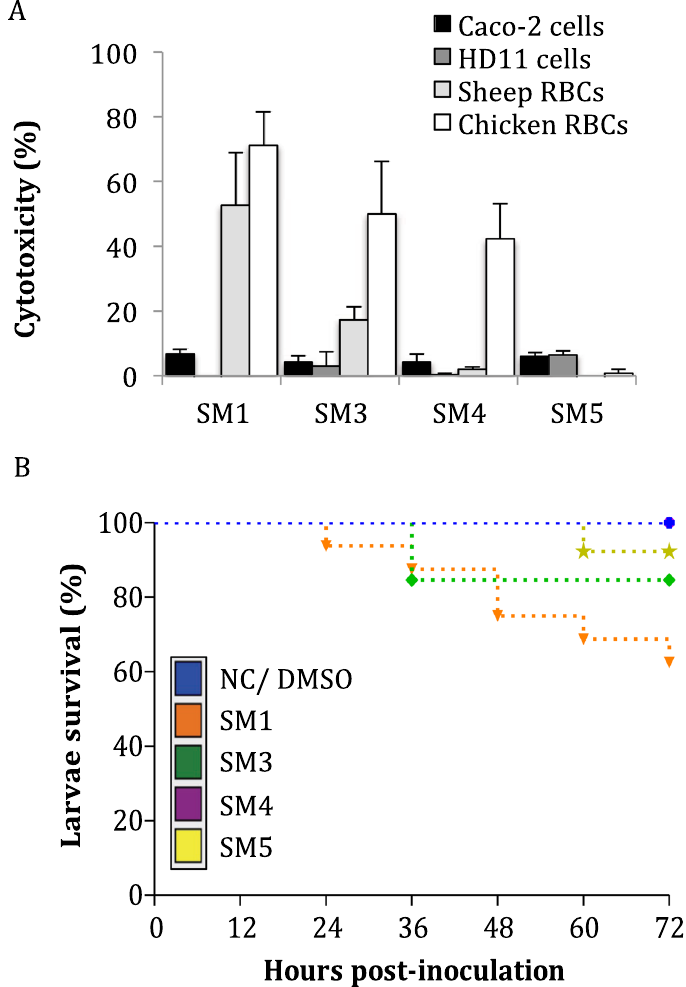
Figure 4. Toxicity of the four selected small molecules (SMs) on several eukaryotic models. ( A ) Cell toxicity and hemolytic activity of the SMs after 24 hrs and 1 hr treatment with 200 μ M, respectively. Data were normalized with a 0.1% triton-100X control. Bar: standard deviation; n = 8 replicates per group. ( B ) Galleria mellonella larva survival rate after a single treatment with 12.5 μ g of SM per larva. Larva death was monitored every 12 hrs for three days after treatment. Both untreated larvae (NC) and larvae treated with 1% dimethyl sulfoxide (DMSO) had 100% survival (blue line). RBCs: red blood cells; n = 15 replicates per group.